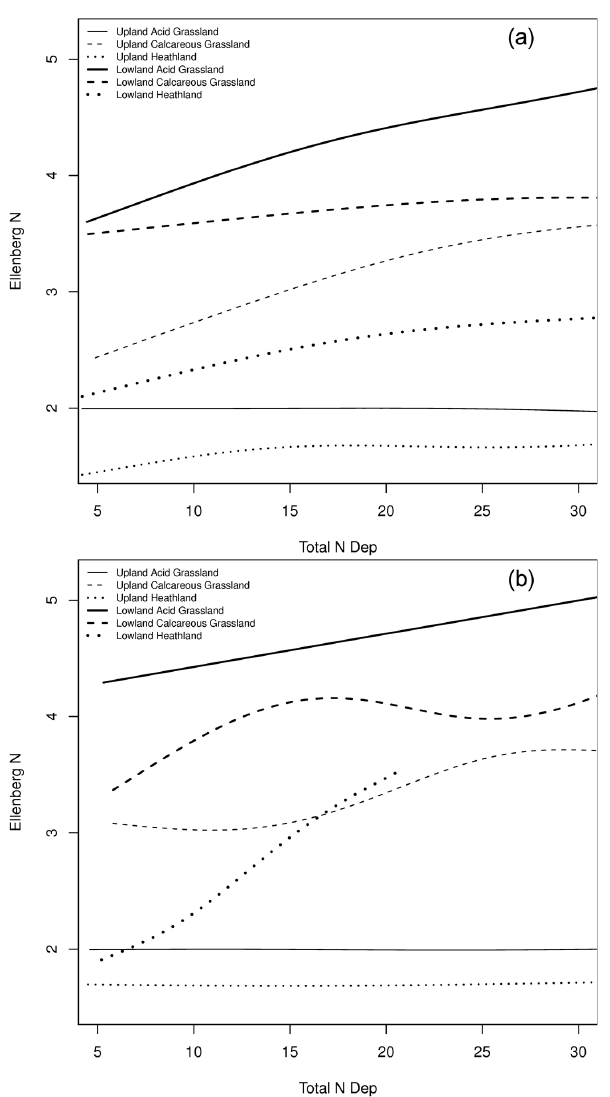
Fig. 7. Modelled response of Ellenberg N scores against total inor- ganic N deposition (kgNha − 1 yr − 1 ) using data from (a) the Vascu- lar Plant database and (b) the BSBI local change